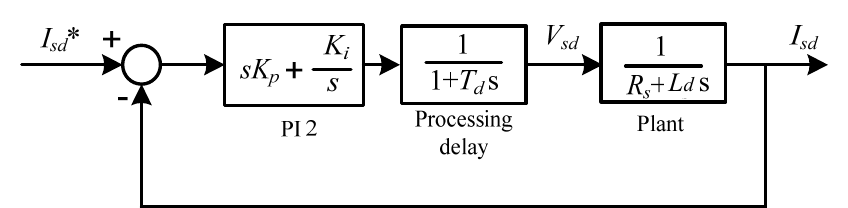
Figure 8. Current control loop of